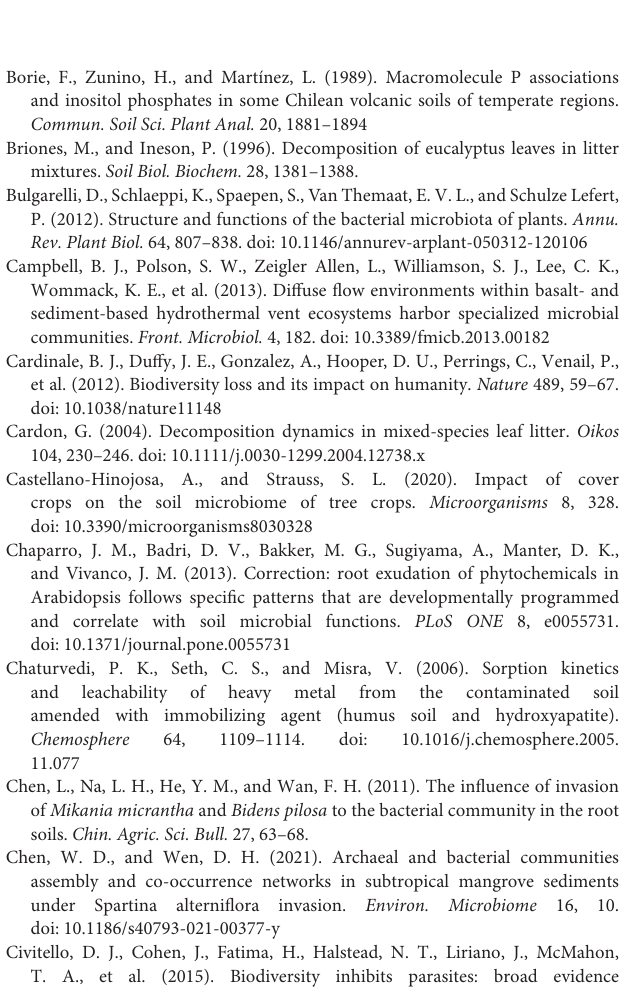
Supplementary Table S1 | The total bacterial community composition at the phylum levels in soil with different treatment. Supplementary Table S2 | The total fungal community composition at the phylum levels in soil with different treatment. Supplementary Table S3 | Network properties of soil microbial communities in different pattern. Supplementary Table S4 | Network properties of soil microbial communities according to development